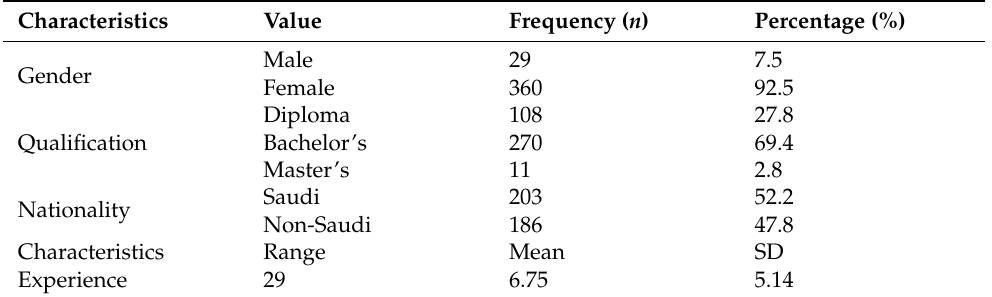
Table 1. Frequency Distributions of the Participants’ Sociodemographic Characteristics ( n =